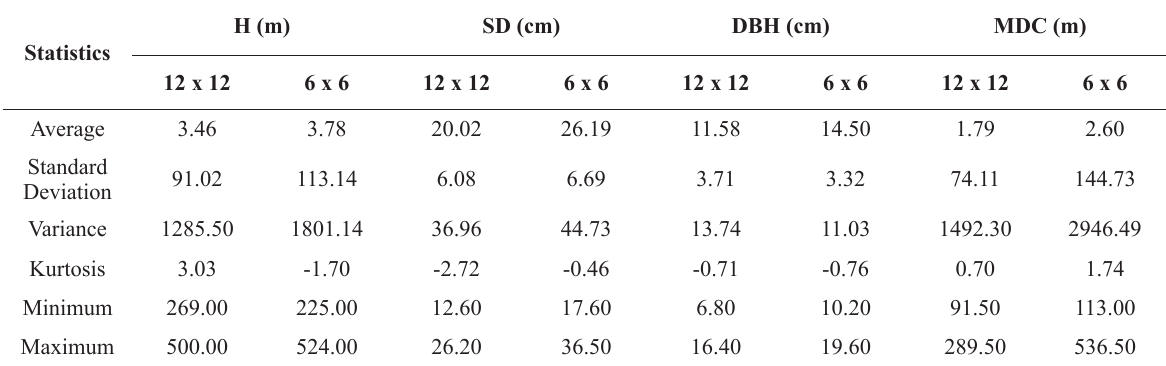
Height (H), stem diameter (SD), diameter at breast height (DBH) and mean diameter of crown (MDC) of Aleurites fordii , in agroforestry systems (12 x 12 and 6 x 6), the plants were five years